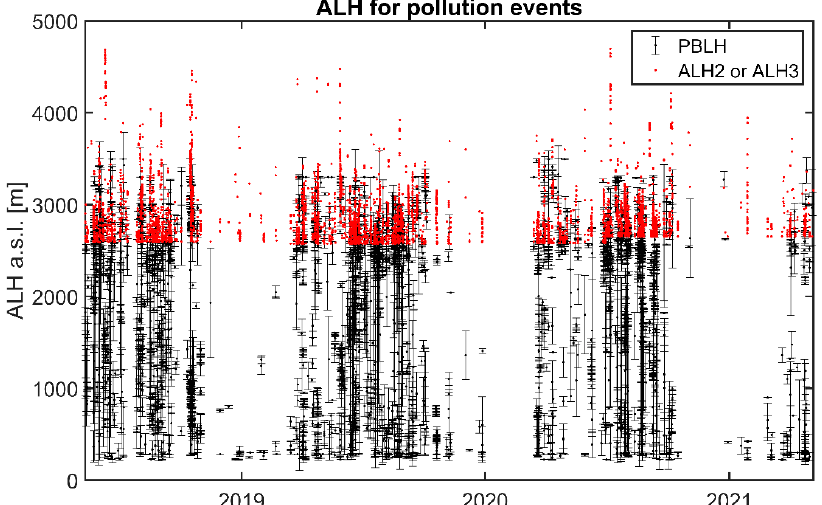
Figure 15. PBL height retrieved with in-house algorithm. ALH2 and ALH3 provided by a ceilometer are shown as well. The error bar for PBL height represents the std (±1 σ ) over a 30 min average. An example of the missing ALH (2 or 3) is visible in Figure 10 where the current algorithm does not catch the ALH around 4 km from 00:00 to ~06:00 UTC.